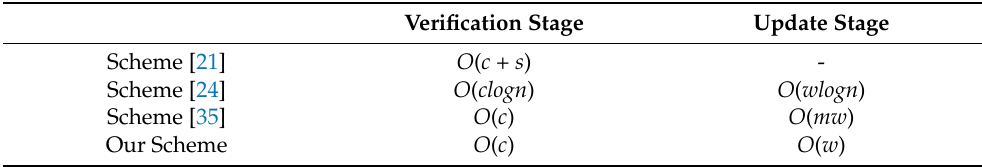
Table 4. Communication overhead complexity